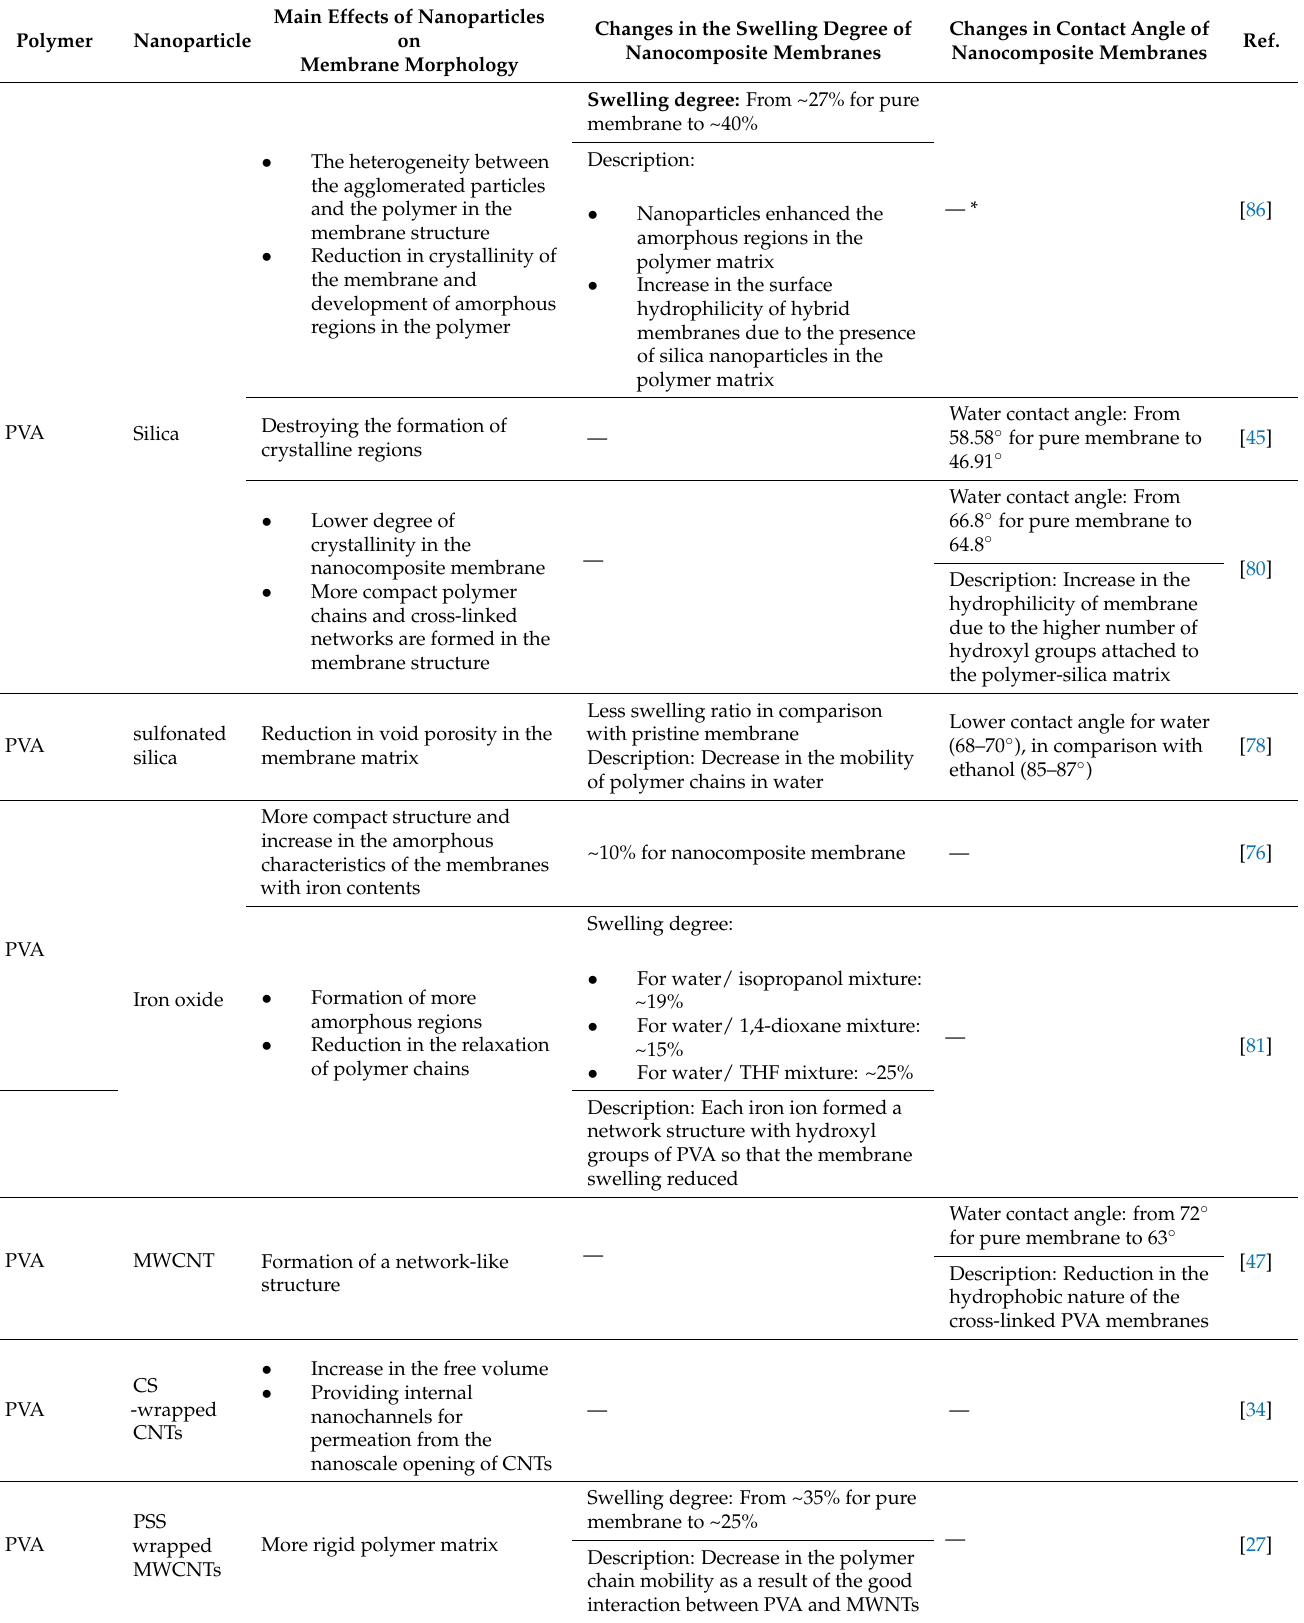
Table 6. The main changes in the morphology, swelling degree, and water contact angle of the nanocomposite